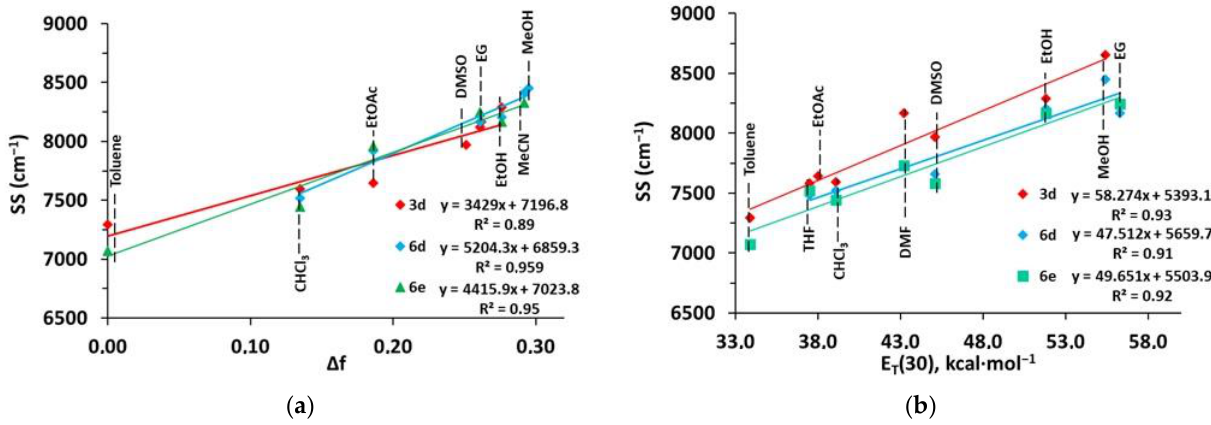
Figure 5. ( a ) The Lippert–Mataga plot showing the Stokes shift (SS) against solvent polarizability (Δf); ( b ) the Dimroth–Reichardt plot showing the Stokes shift (SS) against the ET(30) parameter of DATs 11c , 13a , and 14b .